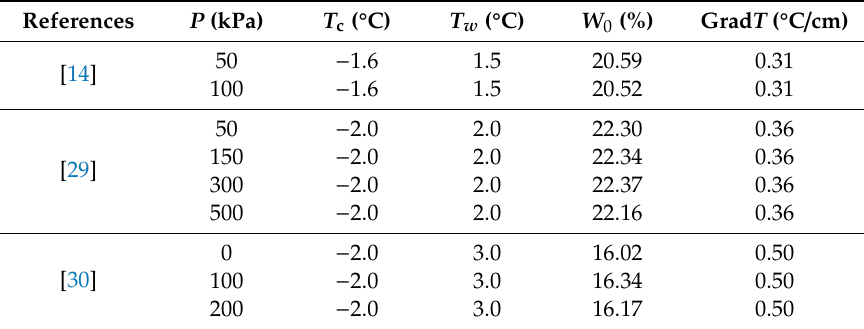
Table 4. Experimental conditions.